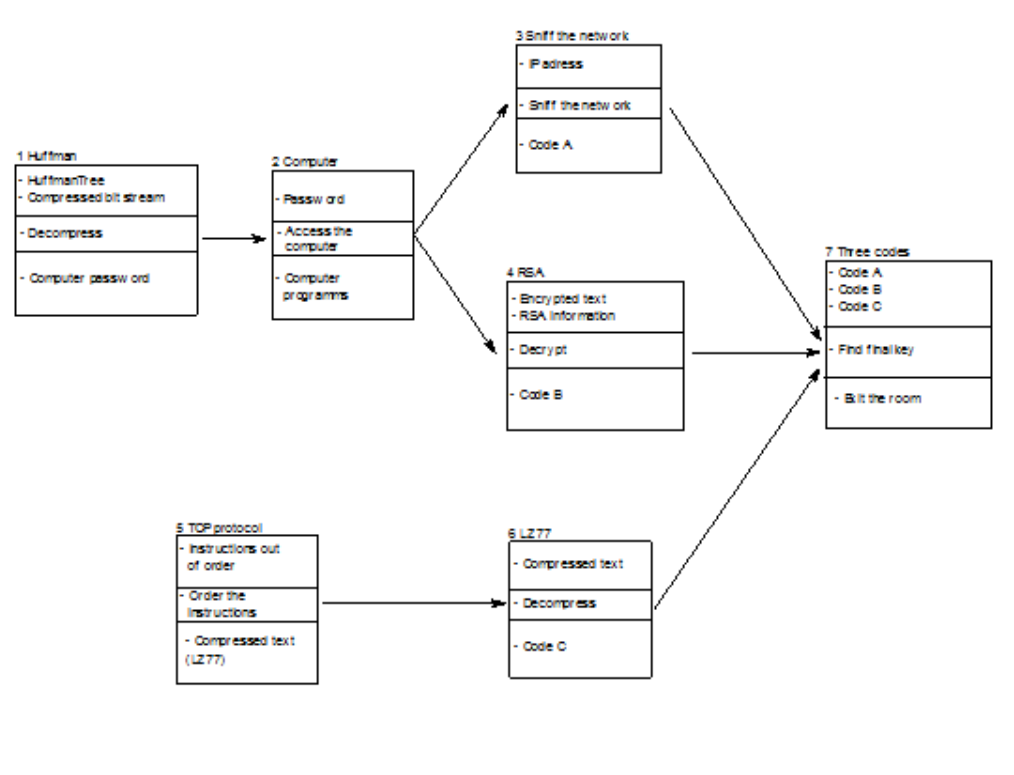
Figure 1. Riddle flow and